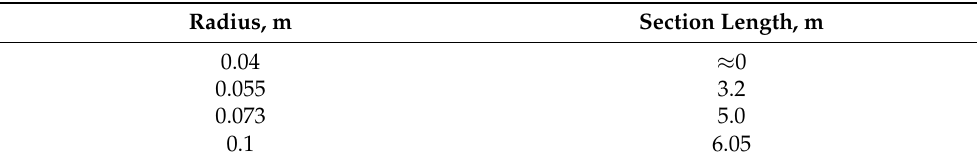
Table 2. Lengths of the temperature deviation sections at different borehole radii.